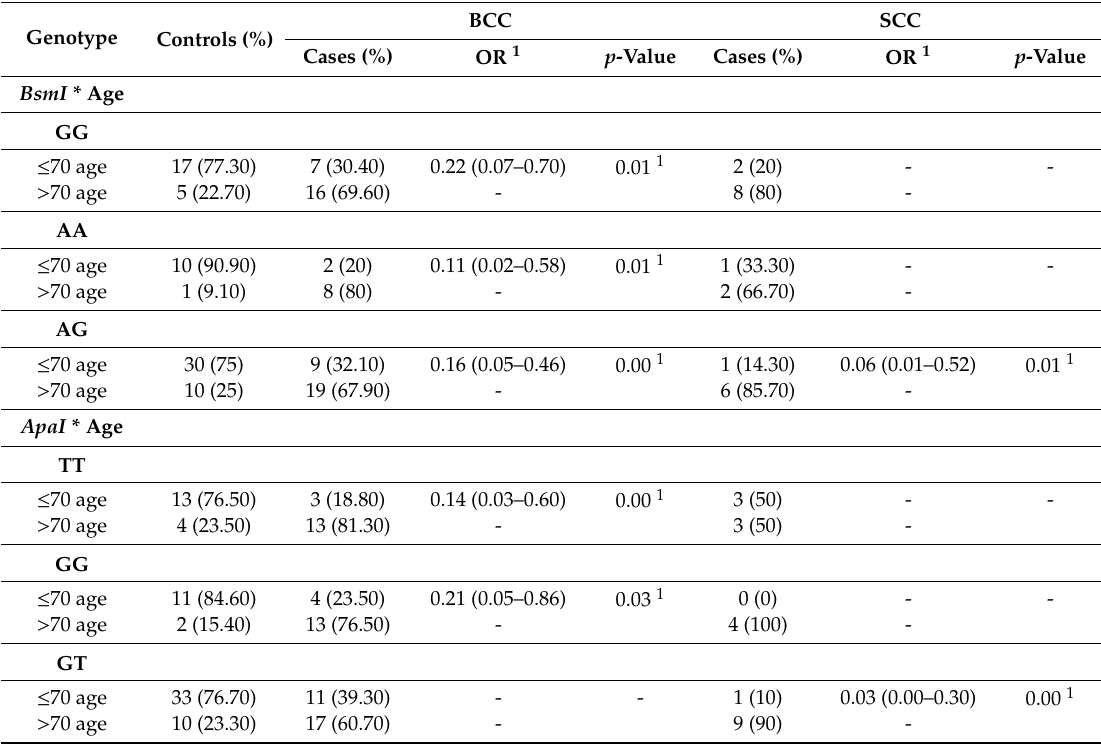
Table 4. BsmI and ApaI polymorphisms for stratum age and skin cancer